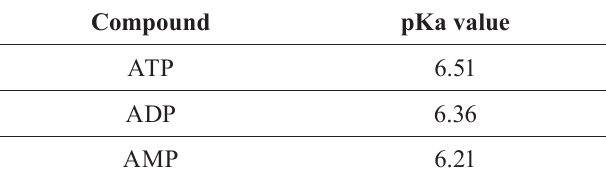
TABLE I - p Ka values of ATP, ADP and AMP